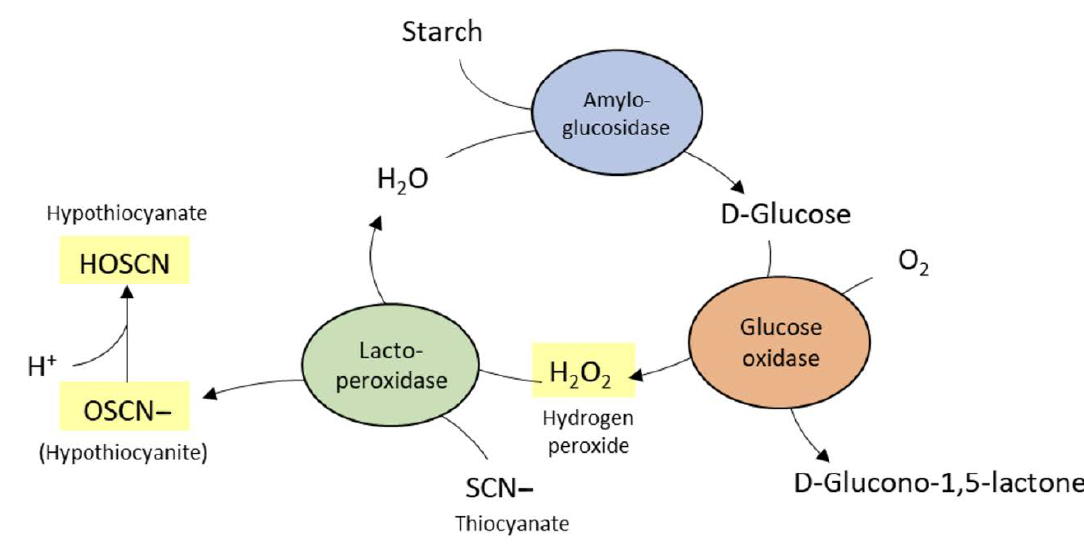
Figure 1. The peroxidase system of the natural saliva defense system generates hydrogen peroxide by the enzyme glucose oxidase and initiates the oxidation of thiocyanate (SCN − ) to hypothiocyanite (HOSCN/OSCN − ) by the enzyme lactoperoxidase (LPO). The enzyme-containing toothpastes abstain from starch and amyloglucosidase for D-glucose delivery. D-Glucose was directly formulated in the toothpastes together with glucose oxidase. Thiocyanate and LPO are only added to the prototype 755 (see Table 2). The prototypes 255, 258, and C58 rely on the endogenous salivary LPO and thiocyanate for the production of